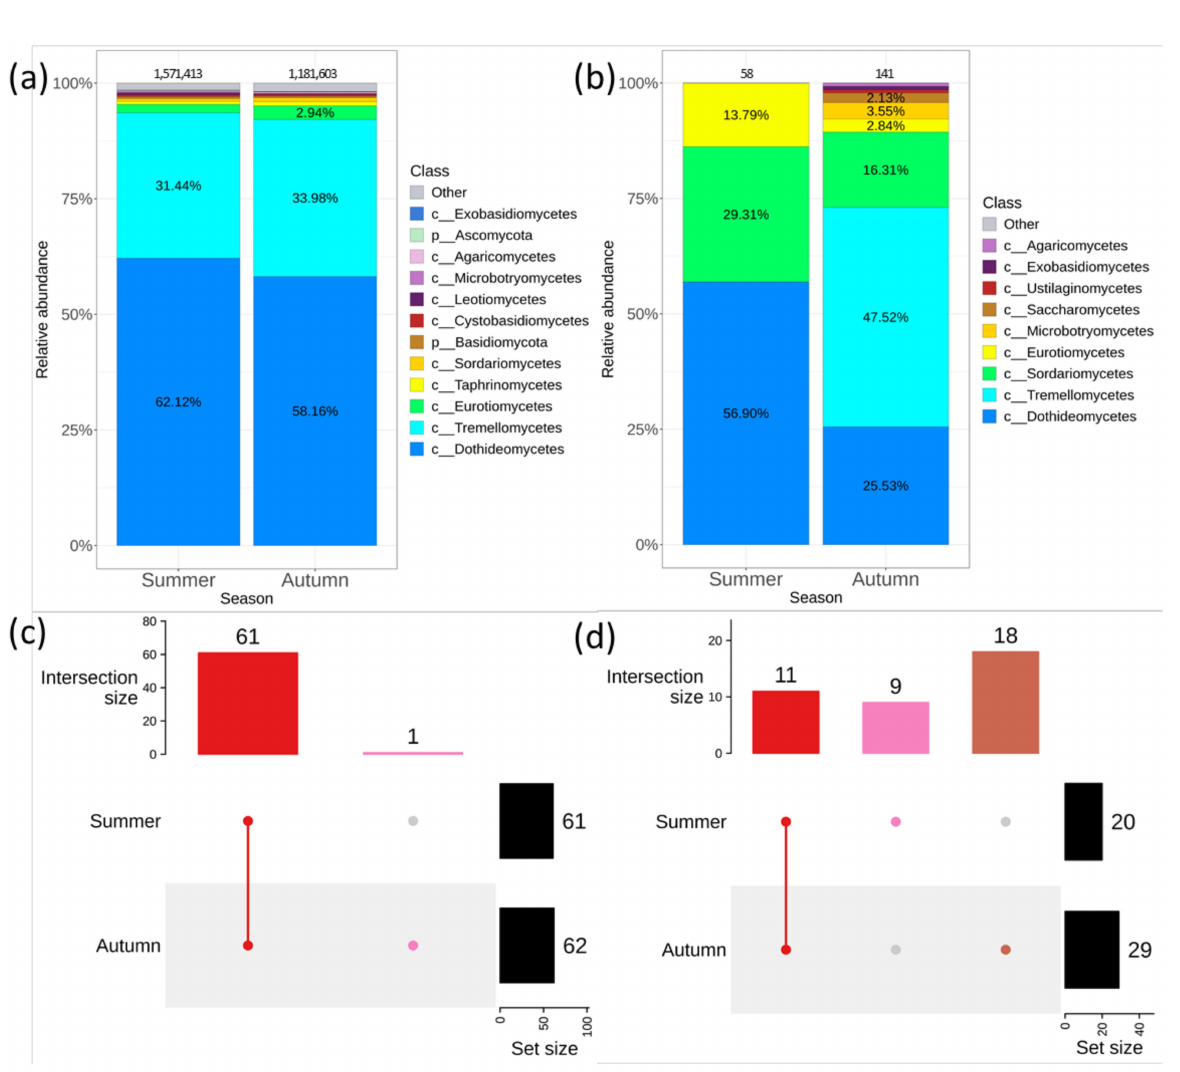
Figure 5. Composition of endophytic fungal community in wild grape Vitis amurensis depends on the season of material collection: ( a ) Class level taxonomical bar plots for the fungal community analyzed by the cultivation-independent approach (next-generation sequencing (NGS)) in summer and autumn; ( b ) Class level taxonomical bar plots for the fungal community analyzed by the cultivation-dependent approach in summer and autumn; ( c ) Genus level UpSet diagrams depicting overlapping taxa of NGS in autumn and summer; ( d ) Genus level UpSet diagrams depicting overlapping taxa of fungal sow in summer and autumn. Taxa were filtered based on relative abundance of >0.1% for each biocompartment. Taxa on relative abundance of <0.1% were removed from UpSet diagram. Number of sequences or strains are shown above taxonomical bar